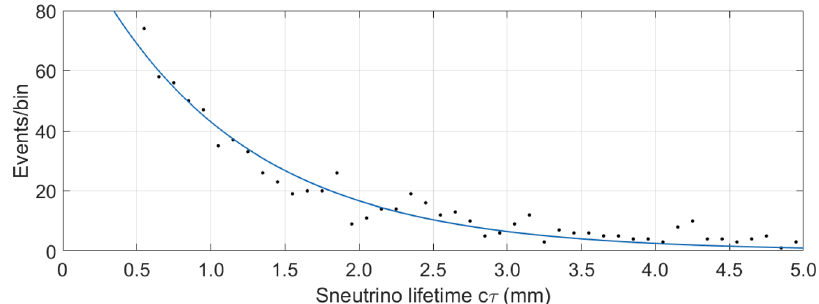
Figure 7 . The fit of an exponential to the lifetime distribution of the sneutrino for BP-I. The amount of data corresponds to 3000 fb − 1 at